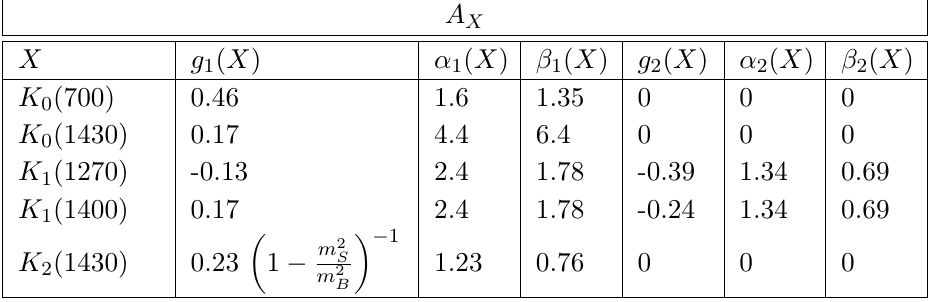
Table 2 . Values of the coefficients for the for factor A X used in this work that were taken from [74, 75] and